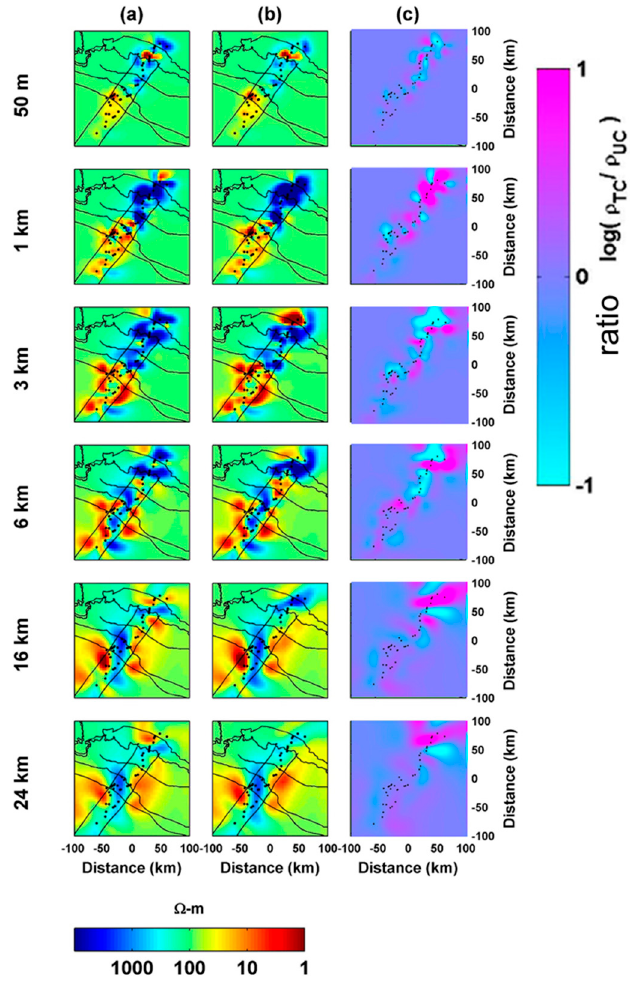
Figure 13. The depth slices of 3D inverted models with projected tectonic features and MT sites ( a ) topographic distorted data, ( b ) topographic corrected data and ( c ) ratio of log of cell resistivities of two models ( a , b ).